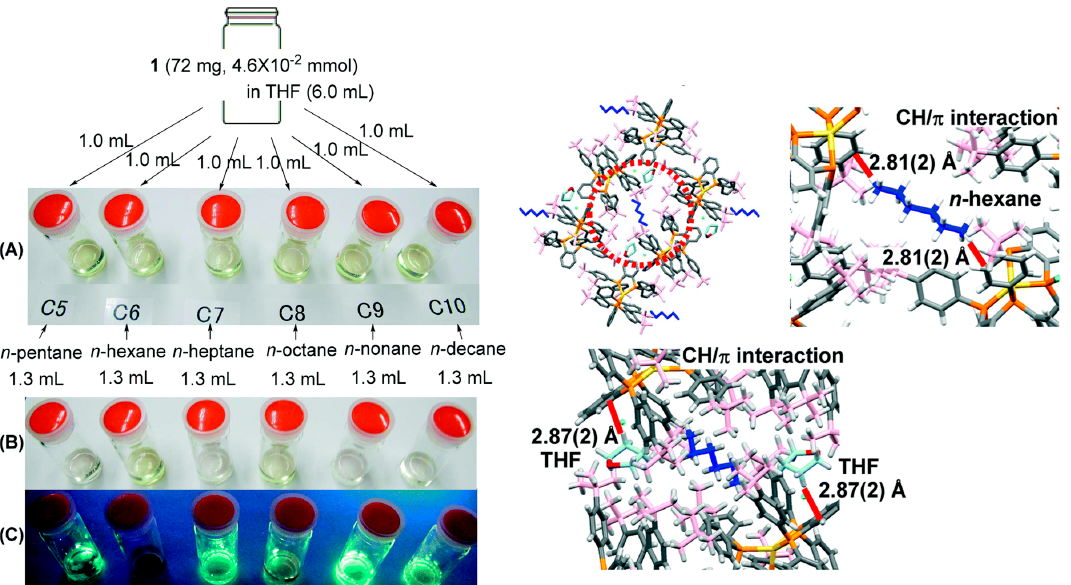
Figure 5. (Left) Recrystallization procedure with THF and alkanes: ( A ) image of the solutions just after alkane addition; ( B ) image of the solutions after 12 h; and ( C ) emission images; λ exc = 365 nm. (Right) Packing view (100) of 6 recrystallized from THF / hexane. Magnified view of the CH ··· π interactions (red lines) between n-hexane and 6 + (two THF molecules and two 4-tert-butylphenyl groups are omitted for clarity) and magnified view of the CH ··· π interactions (red lines) between THF and 6 + . Reproduced with permission from Osawa, M. et al., Dalton Trans. ; published by Royal Society of Chemistry, 2019 [28].